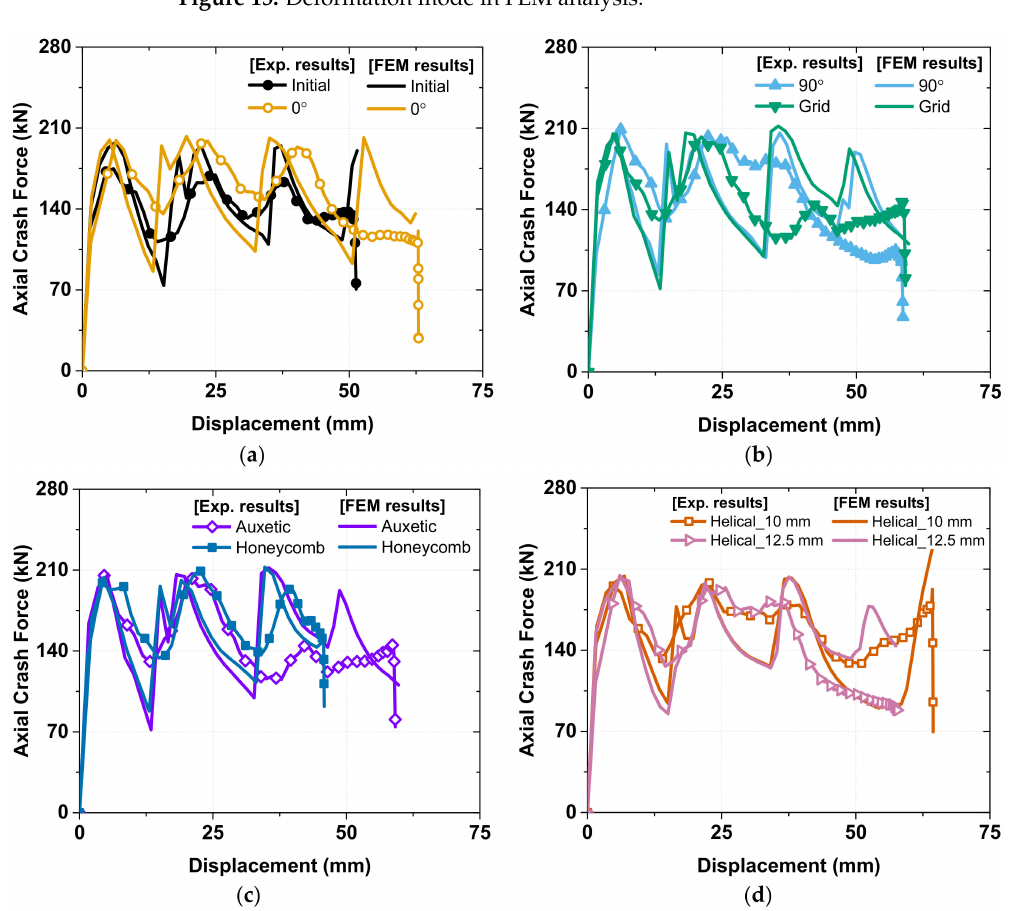
Figure 16. Comparing Axial crash force between FEM analysis and Experiment: ( a ) Initial and 0 ◦ ; ( b ) 90 ◦ and Grid; ( c ) Auxetic and Honeycomb; ( d ) helical with pitch of 10 mm and helical with pitch of 12.5